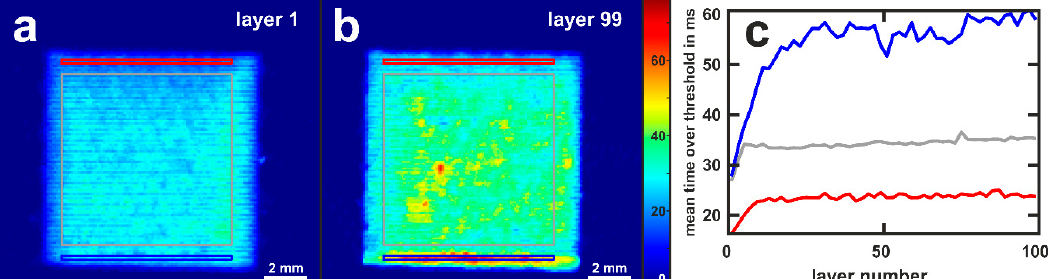
Figure 8. Time over threshold (TOT) for an apparent temperature value of 700 K for the volume A, built with standard parameters. The exposure was performed horizontally from top to bottom in both depicted layers ( a ) Layer 1, ( b ): Layer 99, ( c ) mean values of the TOT in the areas depicted in a and b in dependence on the layer number. Due to the 90° alternating scan strategy, only every second layer (horizontal scanning) was evaluated here. Red: start region of the layer exposition, grey: middle region, blue: end region.